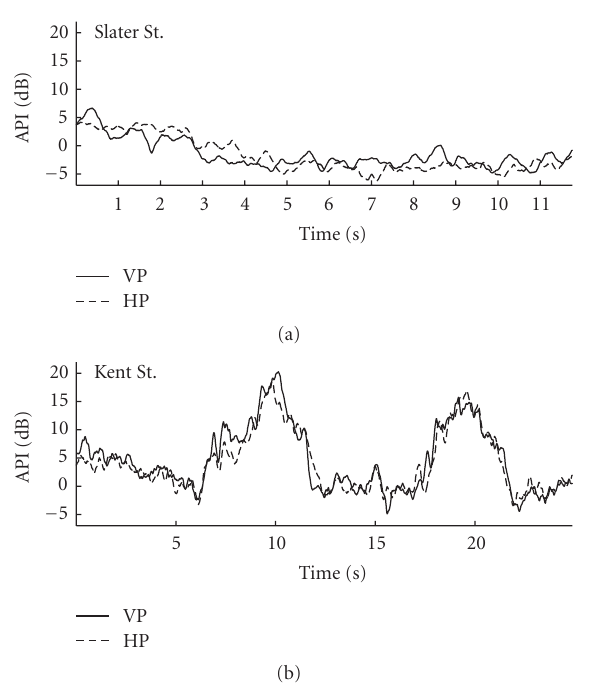
Figure 11: Average XPD measured on Slater Street (a) and Kent Street